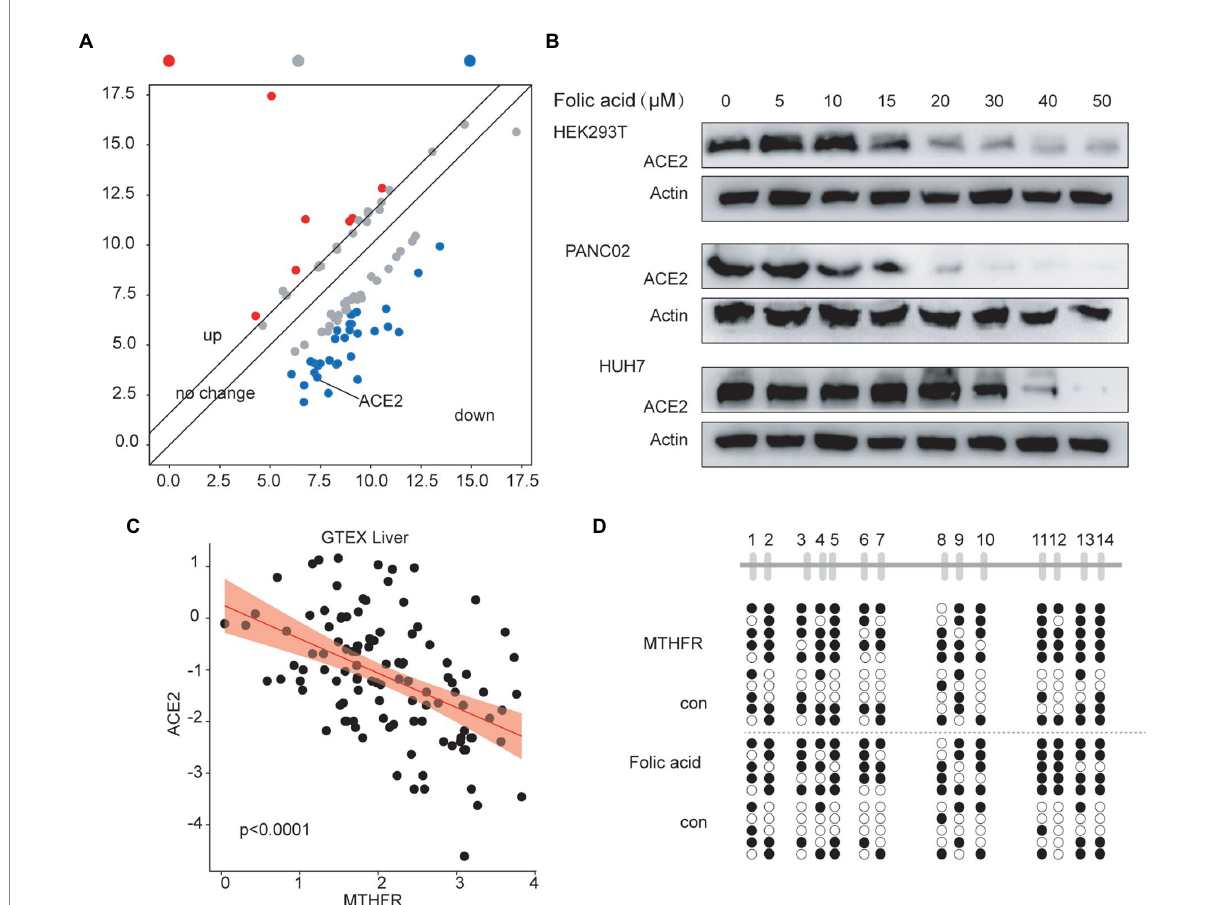
FIGURE 2 The Folic acid system affects the expression of ACE2 by regulating methylation in the promoter region of ACE2. (A) The ACE2 protein level was decreased in MTHFR-overexpressing Huh7 cells, as detected by an antibody microarray assay. (B) Folic acid inhibited ACE2 protein expression in a dose-dependent manner in HEK293T, PANC02, and Huh7 cells. (C) MTHFR expression was negatively correlated with ACE2 expression (liver in the GTEX database, liver cancer in the TCGA database). (D) MTHFR overexpression promoted ACE2 promoter DNA methylation in Huh7 cells. Folic acid promoted ACE2 promoter DNA methylation in Huh7